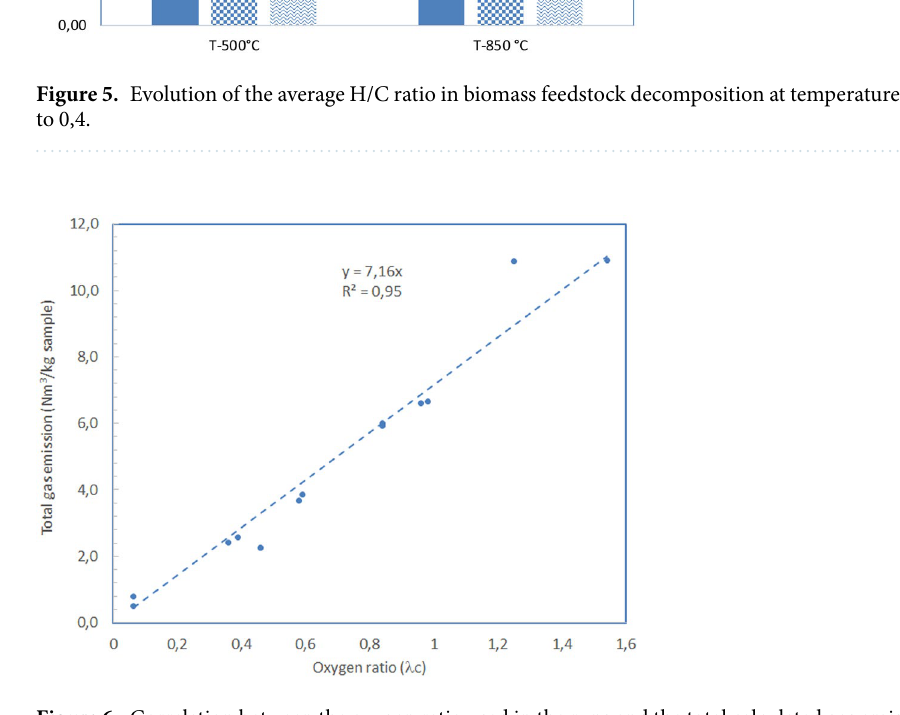
Figure 6. Correlation between the oxygen ratio used in the runs and the total calculated gas emissions.